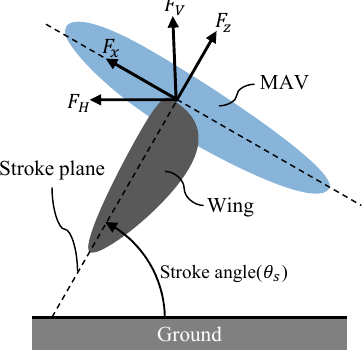
Figure 21. Force direction at an inclined stroke angle.